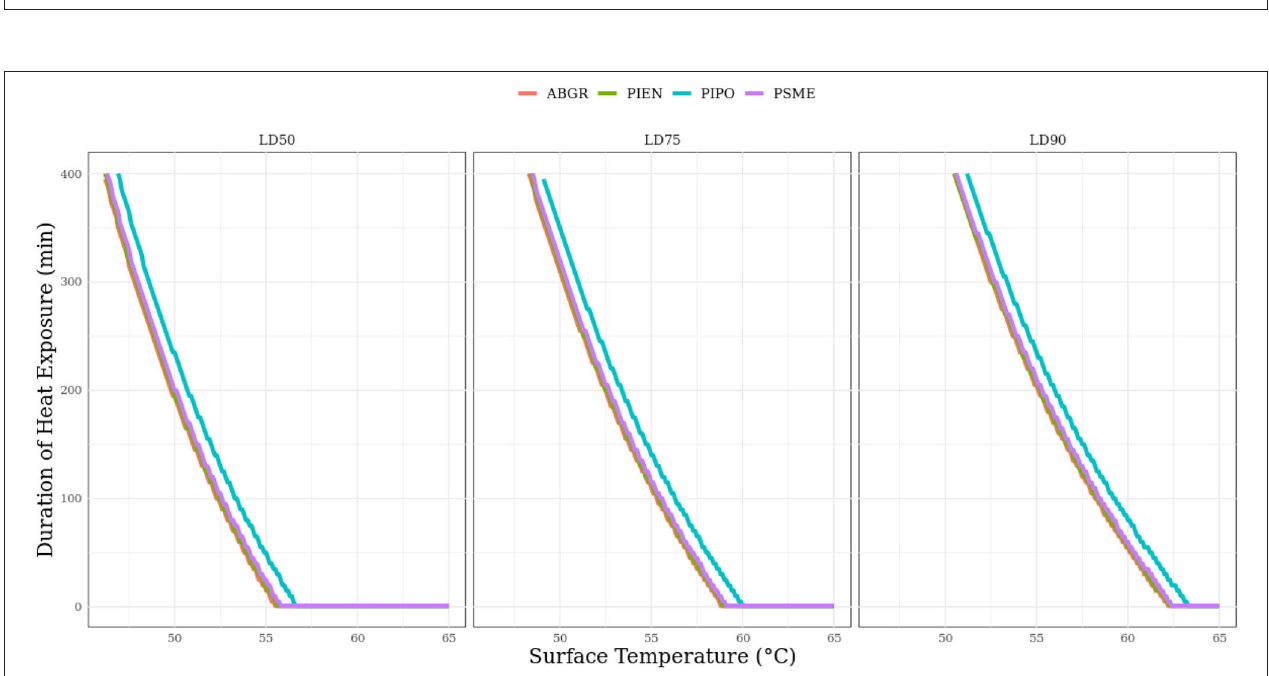
FIGURE 4 | Lethal dosage curves for Abies grandis (ABGR), Picea engelmannii (PIEN), Pinus ponderosa (PIPO), and Pseudotsuga menziesii (PSME). Lethal dosages represent the minimum temperature intensity and duration curves at which modeled survival probabilities are below 0.5, 0.25, and 0.1. Duration values are the minimum exposure time needed to cross these thresholds at a given surface temperature. These represent “lethal dosage” curves for seedling mortality or LD50, LD75, and LD 90, respectively.